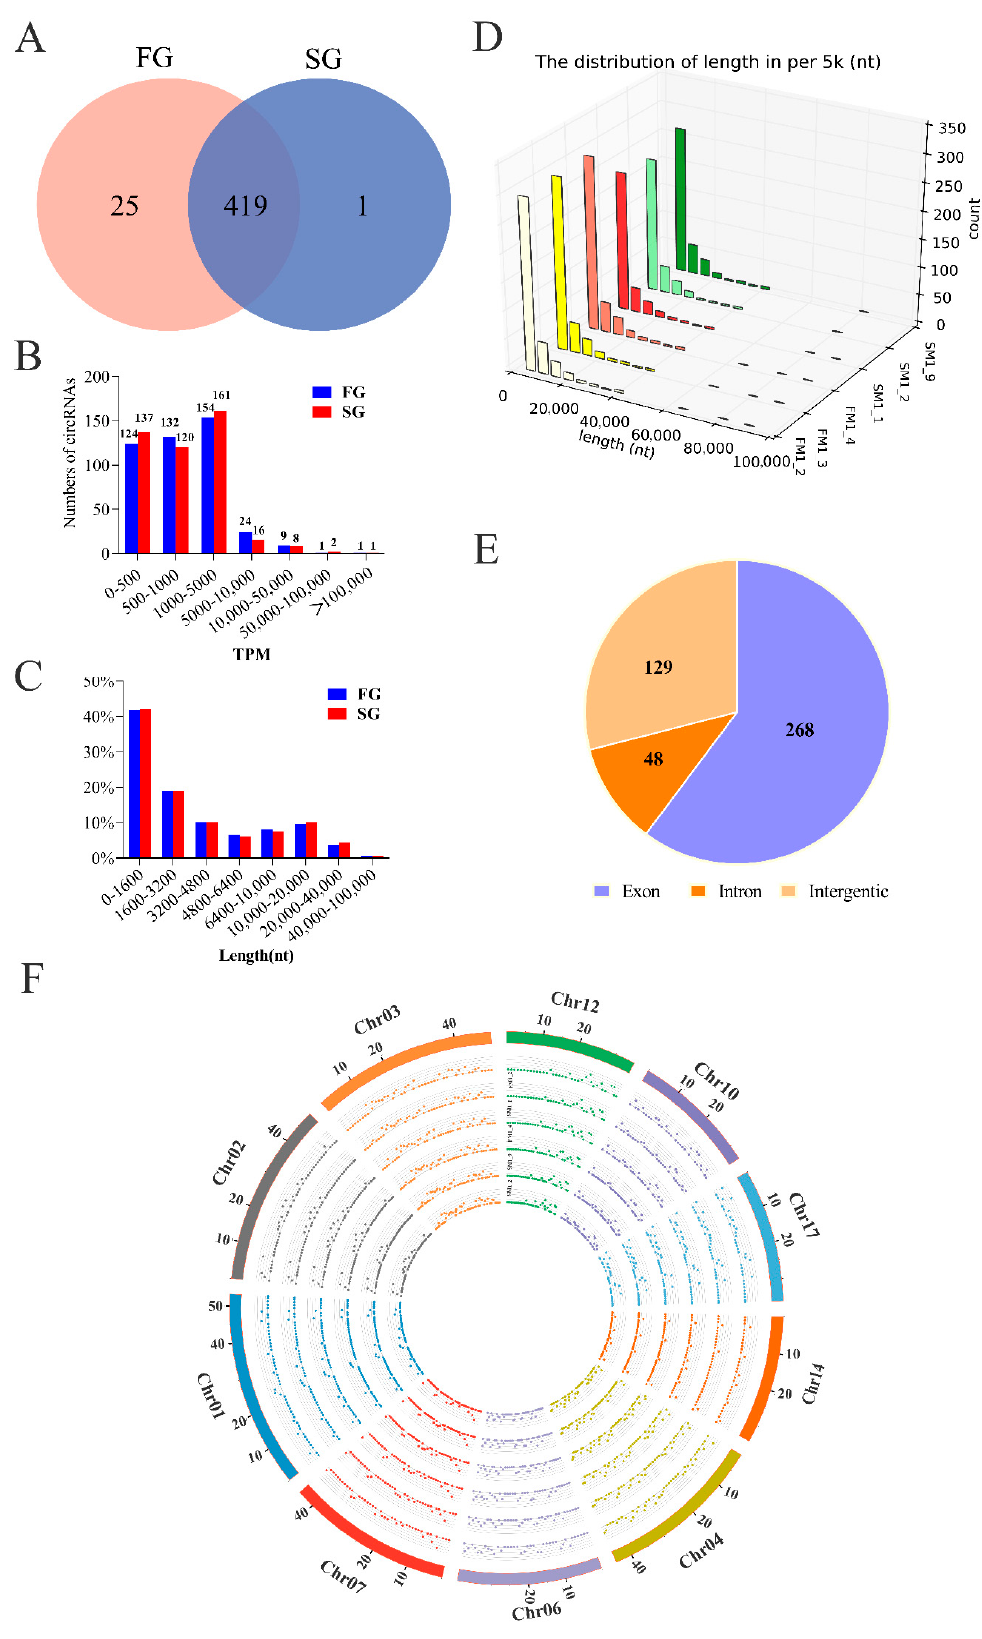
Figure 2. Classification and characterization of circRNAs. ( A ) Venn diagram depicting unique and shared circRNAs in two groups (FG and SG). Overlapping circles present circRNAs that are shared between FG and SG groups. Non-overlap- ping circles indicate circRNAs that are unique in FG (pink) or SG (blue) groups. ( B ) Numbers of circRNAs expression